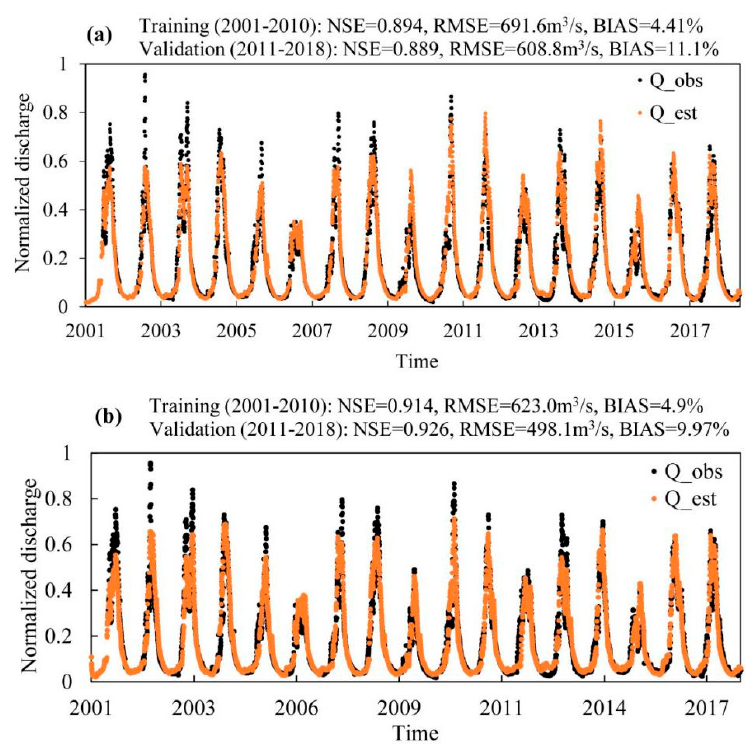
Figure 7. Normalized daily discharge estimates using the segmented TRMM precipitation data ( a ) and Chinese Meteorological Forcing Dataset (CMFD) precipitation data for Nuxia basin ( b ).